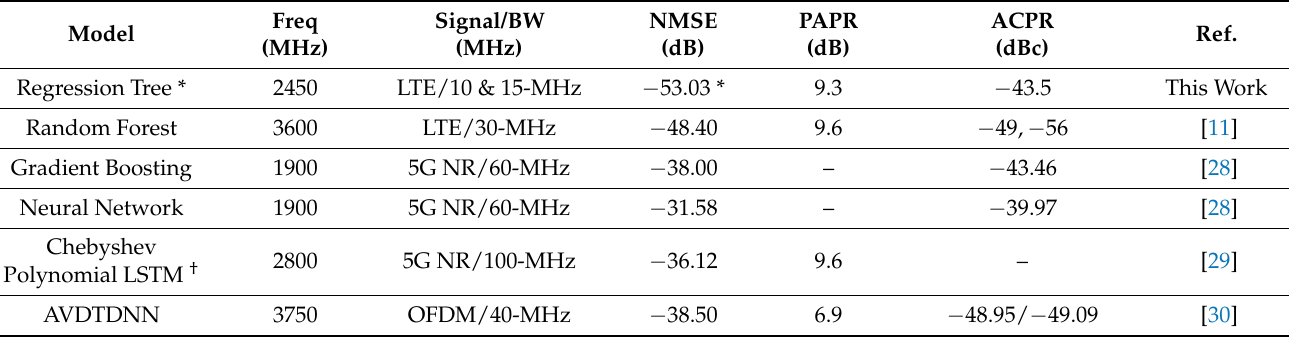
Table 3. Performance comparison with some Machine Learning-based